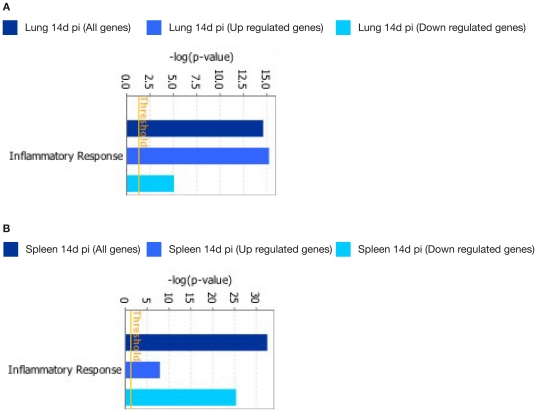
Induction of the inflammatory response network in lung (A) and spleen (B) cells at 14 days p.i.Dark blue: all genes enriched in this network. Light blue: genes that were up-regulated in this network. Cyan: gene those were down-regulated in this network.